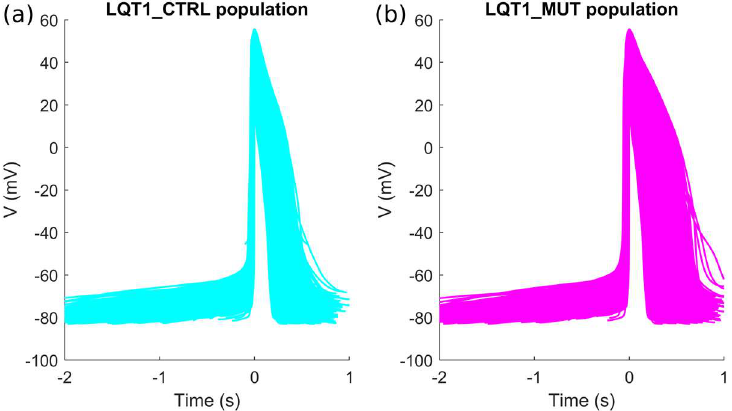
Figure 1. Action potentials included in the two populations built using the I Ks experiments by Moretti et al. [3]: ( a ) LQT1_CTRL; ( b ) LQT1_MUT. A magnified version of this figure is reported as Figure S2 in the supplementary material.